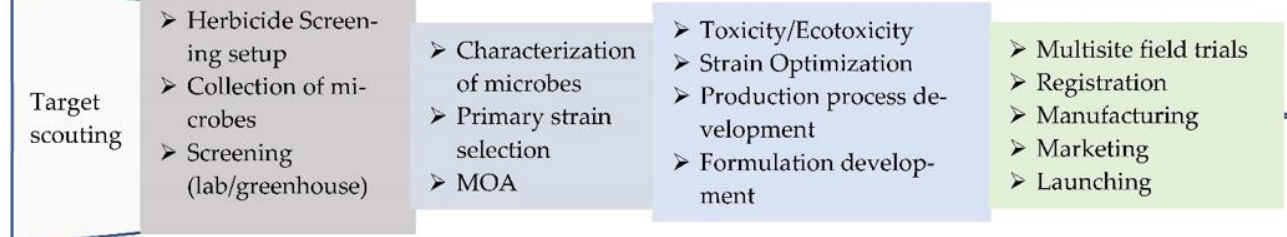
Figure 1. Diagram of steps involved in the development of bioherbicides based on microbes.